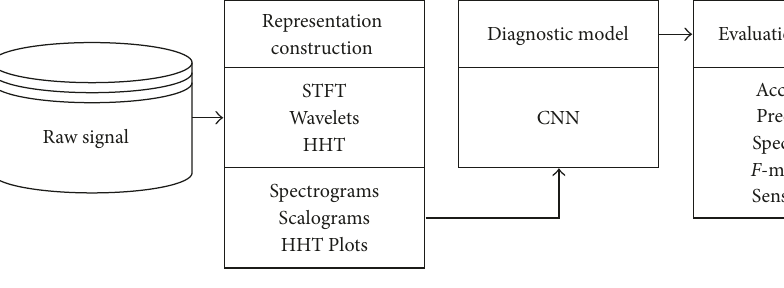
Figure 2: Process of representations for time-frequency